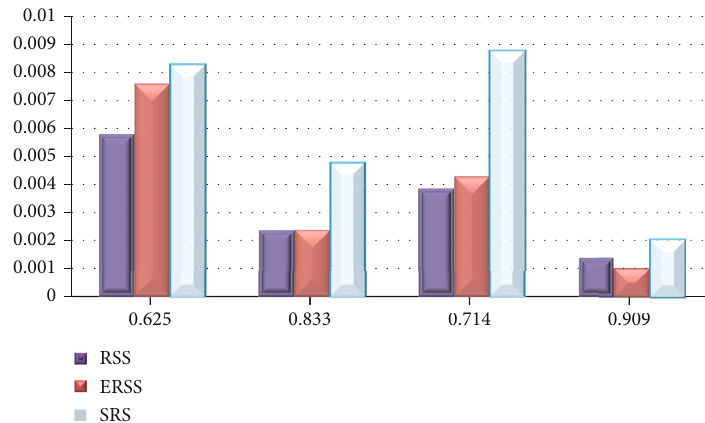
, m = ð 2, 3 Þ . 1 2 Þ